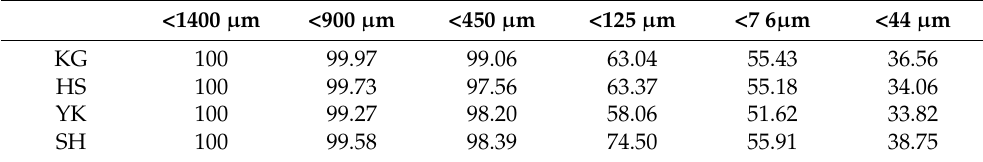
Table 3. Particle size distribution of coals for slurry